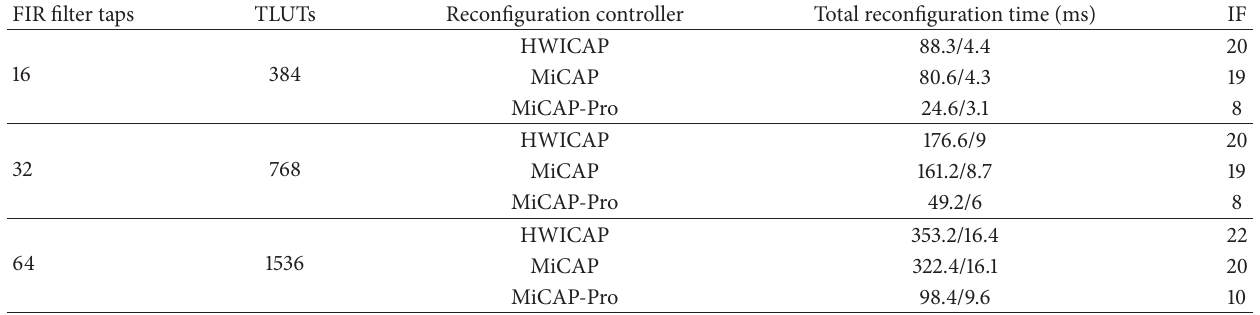
Table 7: Total reconfiguration time with placement constraints.